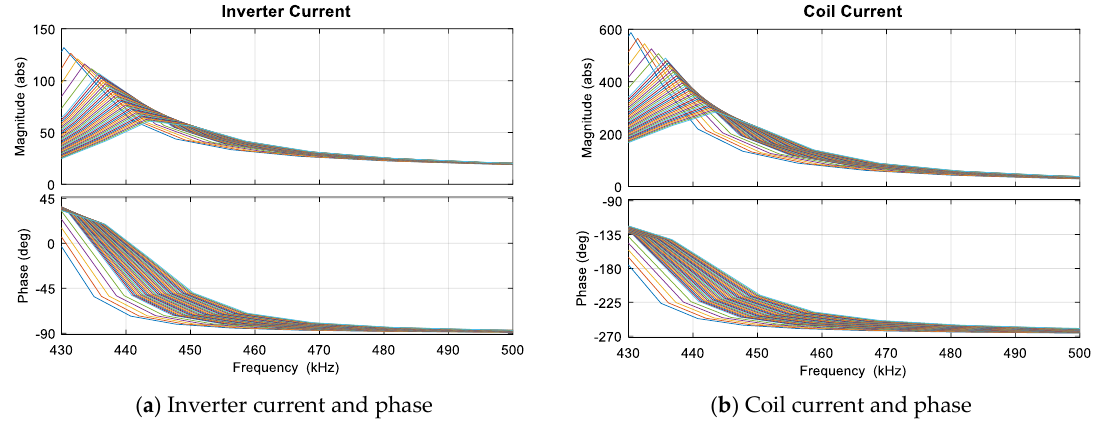
Figure 13. Current and phase of inverter and coil with respect to frequency variation.